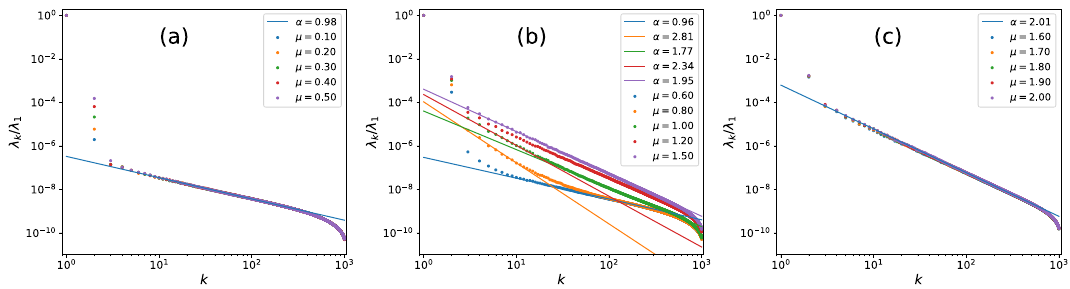
(cid:31) k / (cid:31) Figure 1. Scaled scree plots of of PRBM at various parameters µ . Despite the two dominant modes, 1 } { (cid:31) k ( k α with α 1 for µ 2 for µ 0.5 and α 1.6 , representing chaotic and 3 ) follows a power-law k − ≃ ≃ ≤ ≥ ≥ ( 0.5, 1.6 ) , two-branch scree plots appear with integrable regimes respectively. In the intermediate range µ ∈ the lower part displays a super-Poissonian behavior α > 2 , indicating a NEE regime. The two-branch structure 0.5 , in consistent with the value predicted in Ref. 40 starts to appear at µ =